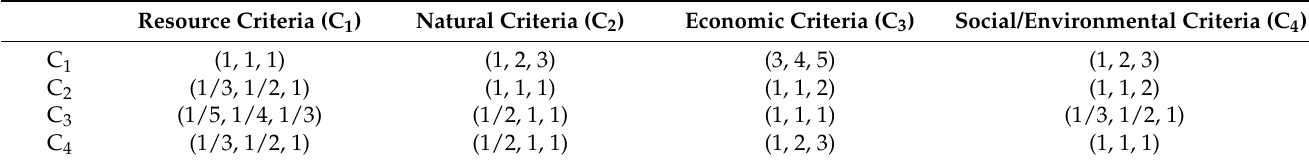
Table A1. Fuzzy pairwise comparison matrix of expert 1 (Weight: 0.3).